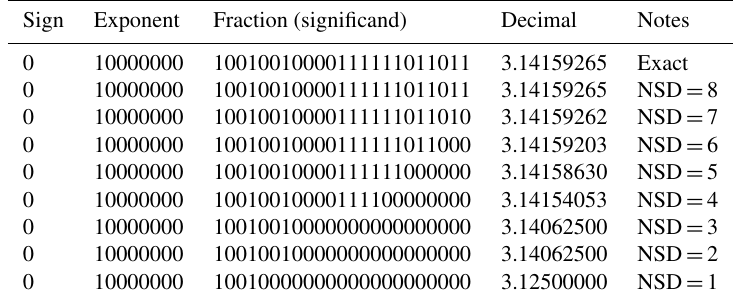
Table 2. Bit Grooming Pi. Same as Table 1 but after varying degrees of Bit